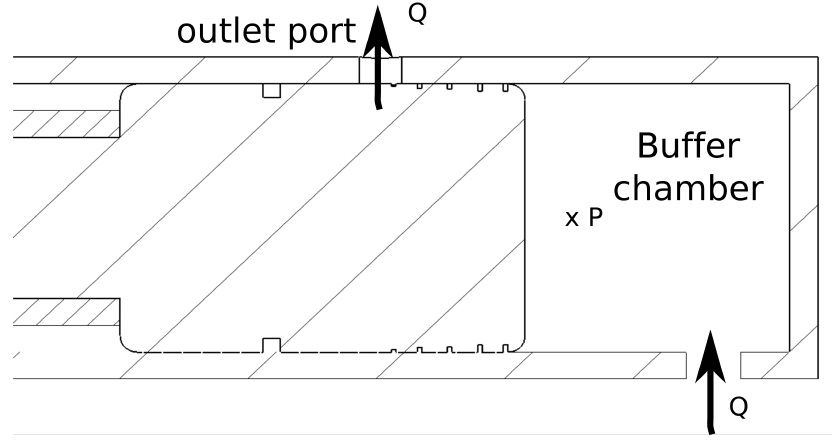
Figure 5. Schemes for experimental set-up of flow rate through buffer chamber in cylinder. The shown position is R5.